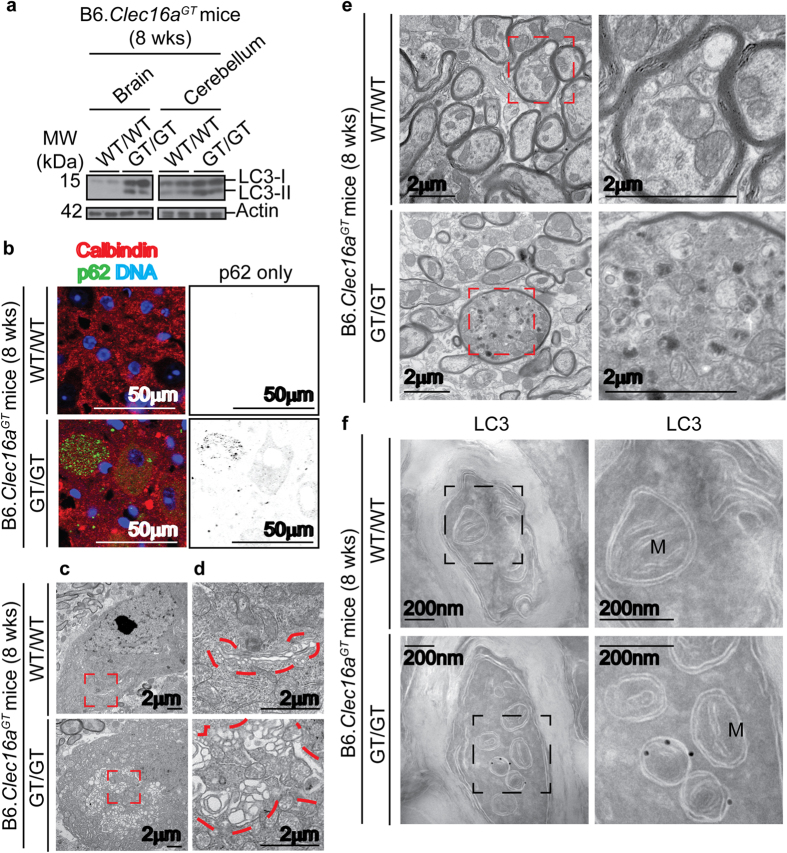
Lack of Clec16a results in LC3 and p62 accumulation and ultrastructural abnormalities in cerebellar neurons.(a) Representative western blot of LC3 protein levels in brain or cerebellum from 8 week old B6.Clec16aGT mice (representative of n = 3 mice/group). (b–e) Images of immunofluorescence for calbindin and p62 (b) and transmission electron microscopy (c–e) from the deep cerebellar nuclei of 8 week old B6.Clec16aGT mice (representative of n = 3 mice/group). Images highlighting intact Golgi stacks and enlarged endomembrane compartment in neurons (c,d) and axons (e) in the deep cerebellar nuclei. Golgi stacks and compartment outlined in red dotted lines (d). (f) Images of cryo-immunoelectron microscopy from immunogold labeling for LC3 (12 nm gold) in section of one axon of Purkinje cell of 8 week old B6.Clec16aGT mice (representative of n = 3 mice/group). Mitochondria are indicated (M).